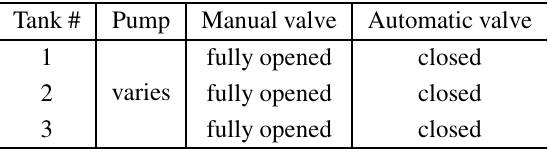
Table 2. Pump-controlled scenario: configuration.